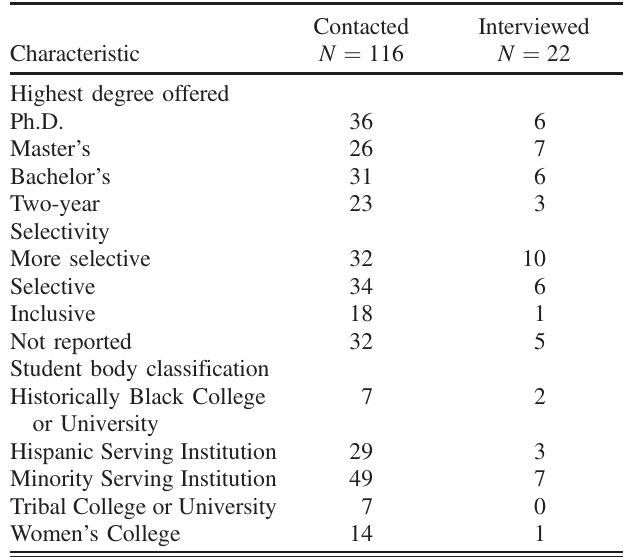
TABLE I. The number of institutions from which individuals were contacted (first column) and interviewed (second column). All classifications were based on the 2018 Carnegie database ( “ Selectivity ” from the Ugrad profile variable).